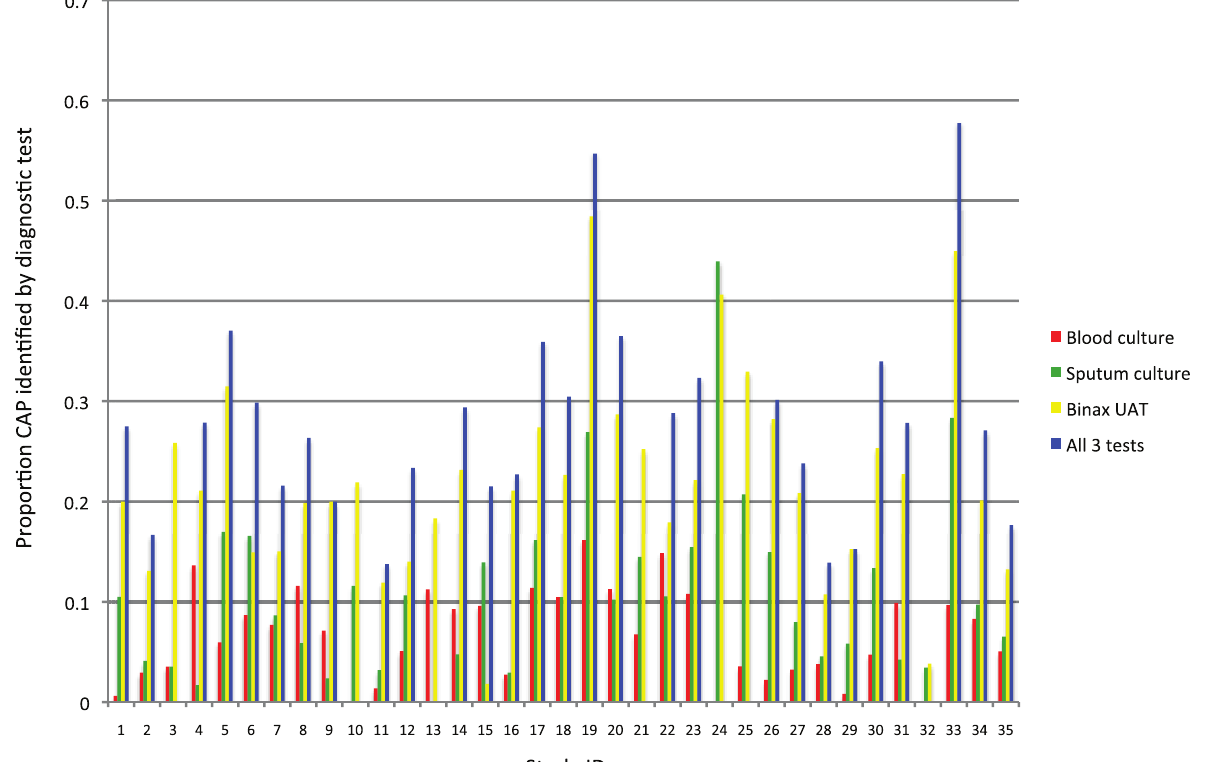
Figure 5. The proportion of community-acquired pneumonia attributable to pneumococcus, according to diagnostic test results, by individual studies 3 .